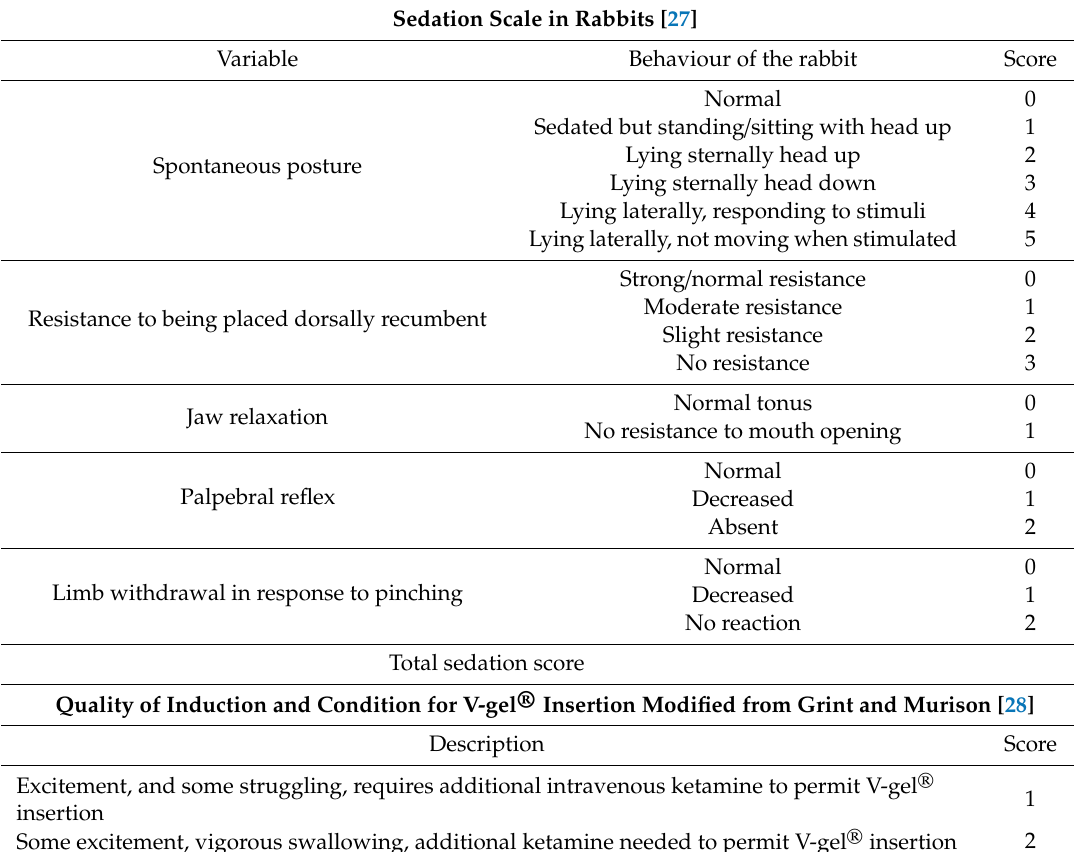
Table 1. Sedation scale [27] and quality of induction and condition for V-Gel ® insertion modified from Grint and Murison [28] used after anaesthesia agents administration in 14 rabbits undergoing surgical creation of critical-sized defects in the calvarial